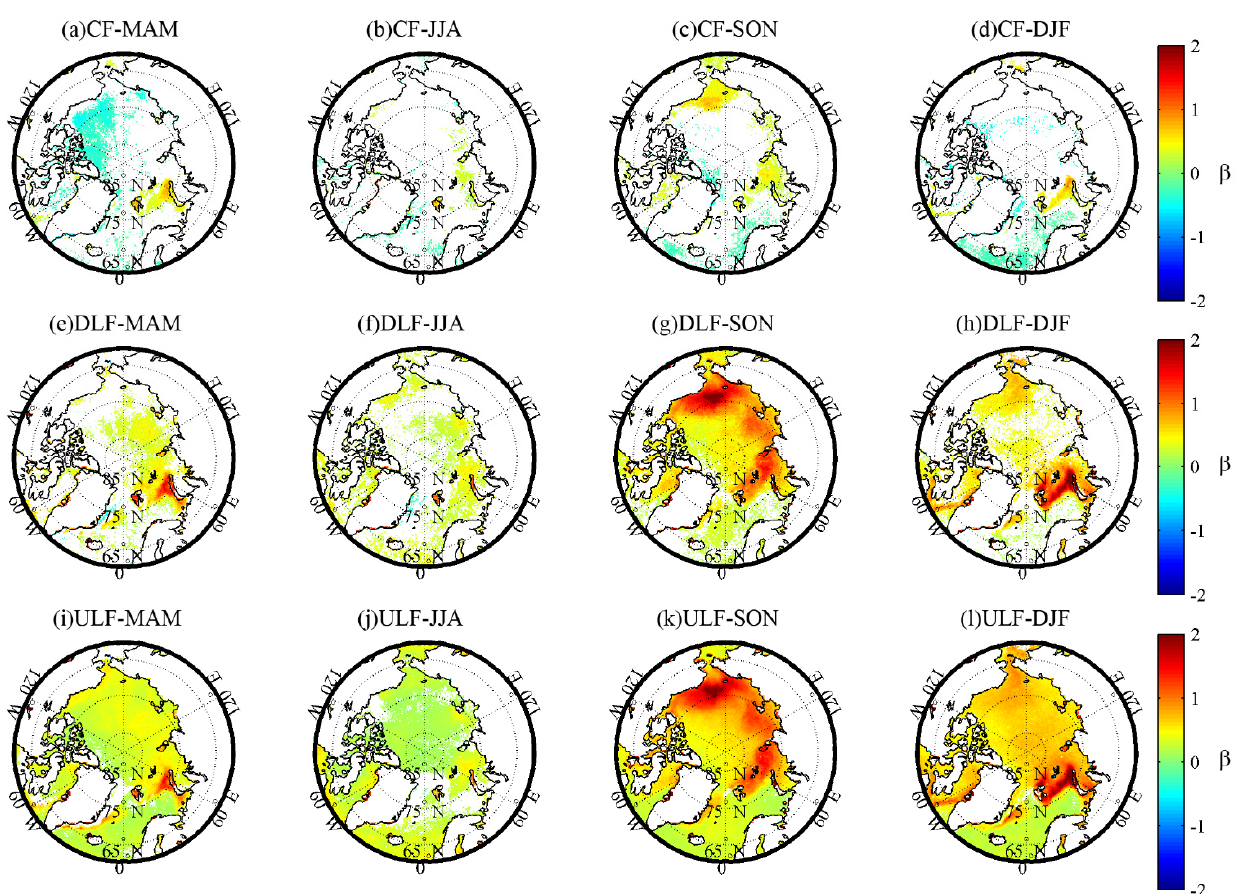
Figure 6. Spatial distributions of β derived by the Sen’s slope test over the seas in Arctic (60°~90°N) for different seasons from 1982 to 2019 at 04:00 LST. ( a – d ) CF in MAM, JJA, SON, and DJF. ( e – h ) DLF in MAM, JJA, SON, and DJF. ( i – l ) ULF in MAM, JJA, SON, and DJF. The colored regions are at a significance level of 95%.